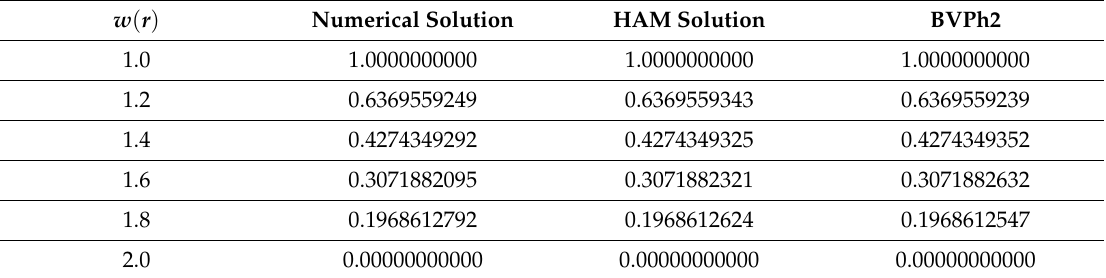
Table 1. Comparison of numerical, HAM, and BVPh2 methods for the velocity profile.